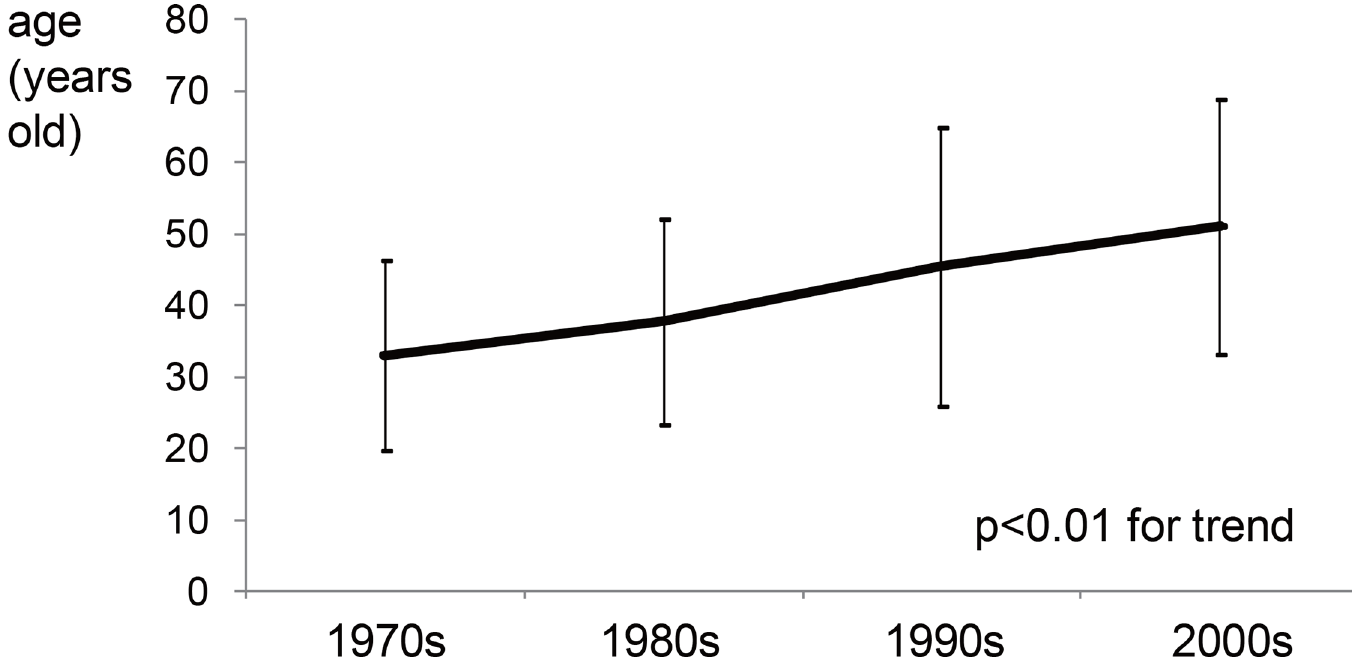
Fig 3. The temporal changes in the age of the onset of PIGN over the four decades. Average age ± standard variation.